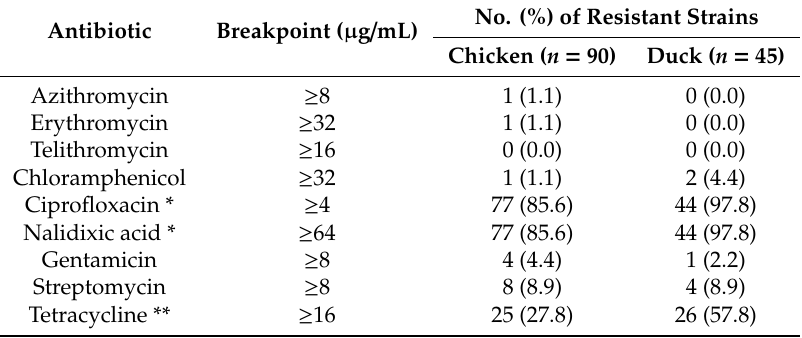
Table 3. Antibiotic resistance of C. jejuni strains from raw chicken and duck meat.